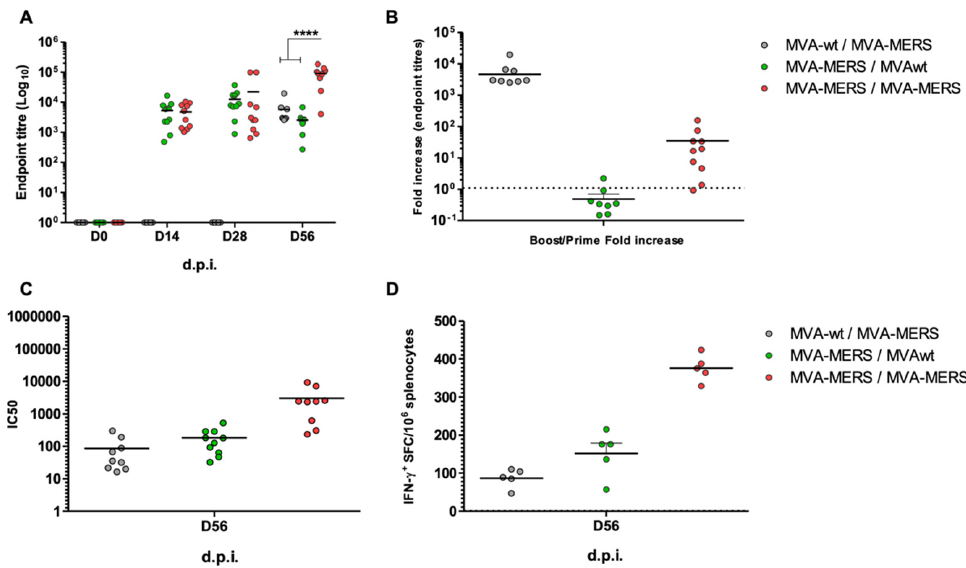
Figure 2. Humoral and cellular immunogenicity of MVA-wt and MVA-MERS prime–boost vac- cination in BALB/c mice. Balb/c mice (n = 10 per group) were intramuscularly immunised with 10 7 PFU as follows: Group 1: MVA-wt/MVA-MERS (grey symbols); Group 2: MVA-MERS/MVA-wt (green symbols); and Group 3: MVA-MERS/MVA-MERS (red symbols). Serum samples were col- lected pre-vaccination at 0 d.p.i, at 28 d.p.i (post-prime), and 56 d.p.i (post-boost). Anti-MERS-CoV spike IgG antibodies were measured using ELISA at all time points, reported as Log10 endpoint titres ( A ). The fold increases in IgG Ab endpoint titres from the prime time (28 d.p.i) to the boost time (56 d.p.i) are presented ( B ). Neutralisation activity of serum antibodies at 56 d.p.i. was confirmed via MERSpp neutralisation assay ( C ), presented as the serum dilution that showed inhibitory concentration of 50% of the pseudoviruses (IC50). At 56 d.p.i, IFN- γ ex vivo ELISpot was performed on splenocytes, collected at 56 d.p.i ( D ). Mean values are shown as lines. **** indicates p value < 0.0001 by one-way ANOVA test and Bonferroni’s multiple-comparison